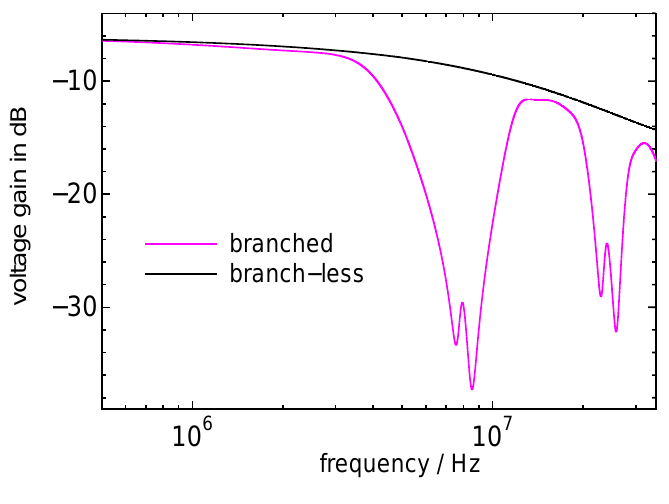
Figure 7. Voltage gain for the power line